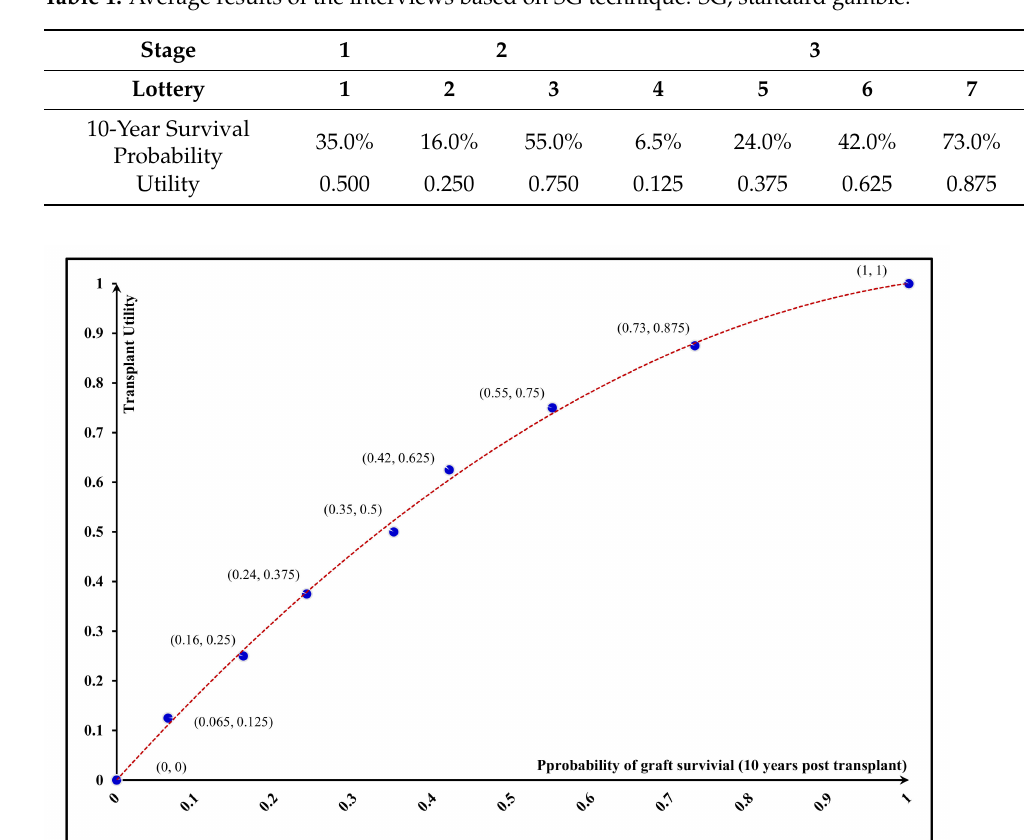
Figure 3. Relationship between probability of graft survival and utility of